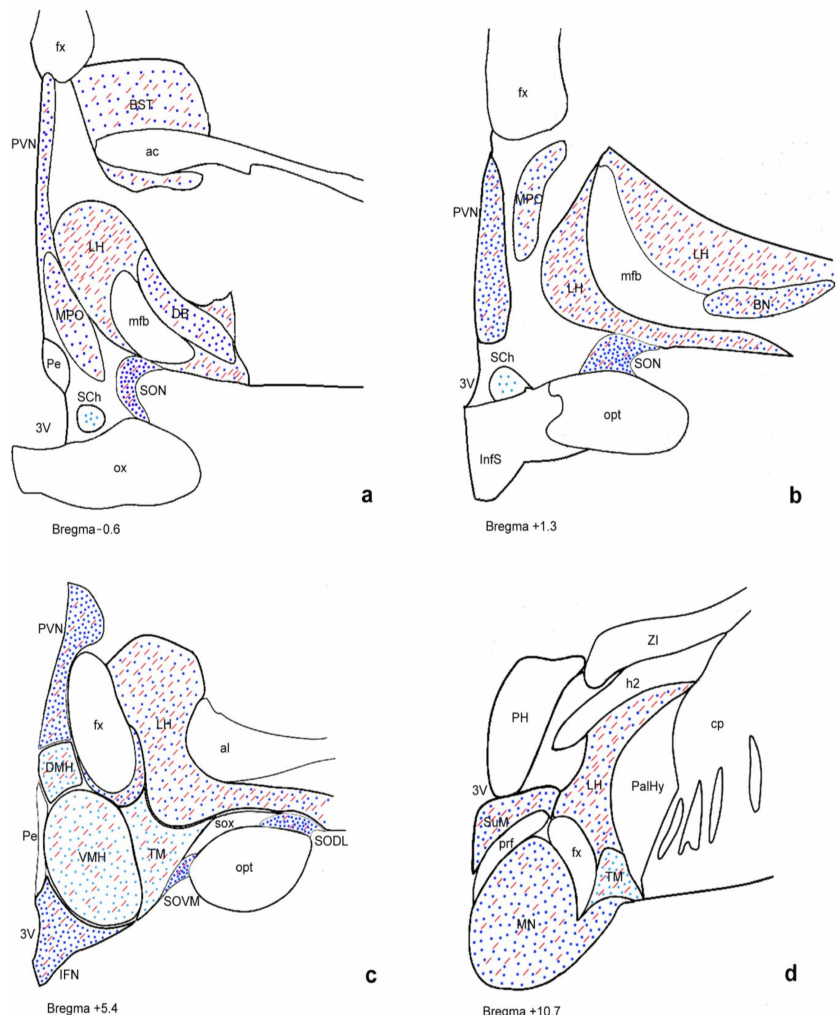
Figure 2. Schematic illustration of GLP-1R distribution in the human hypothalamus. Depiction of GLP-1R-ir cell bodies (blue dots) and GLP-1R-ir fibers (red lines) in four representative coronal sections of human hypothalamus ( a – d ) arranged from rostral ( a ) to caudal ( d ). Dark blue coloring indicates areas showing high staining intensity for GLP-1R and light blue indicates less intense staining. The 3V, third ventricle; ac, anterior commissure; al, ansa lenticularis; BN, basal nucleus; BST, bed nucleus of the stria terminalis; cp, cerebral peduncle; DB, diagonal band; DMH, dorsomedial hypothalamic nucleus; fx, fornix; h2, lenticular fascicle; ic, internal capsule; IFN, infundibular nucleus; InfS, infundibular stalk; LH, lateral hypothalamic area; mfb, medial forebrain bundle; mfb, medial forebrain bundle; MN, mammillary nucleus; MPO, medial preoptic nucleus; opt, optic tract; ox, optic chiasm; PalHy, pallidohypothalamic nucleus; Pe, periventricular nucleus; PeF, perifornical nucleus; PH, posterior hypothalamic area; prf, principal fasciculus; PVN, paraventricular nucleus; SCh, suprachiasmatic nucleus; SON, supraoptic nucleus; SODL, supraoptic nucleus (dorsolateral part); SOVM, supraoptic nucleus (ventromedial part); sox, supraoptic commissure; SuM, supramammillary nucleus; TM, tuberomammillary nucleus; VMH; ventromedial hypothalamic nucleus; ZI, zona